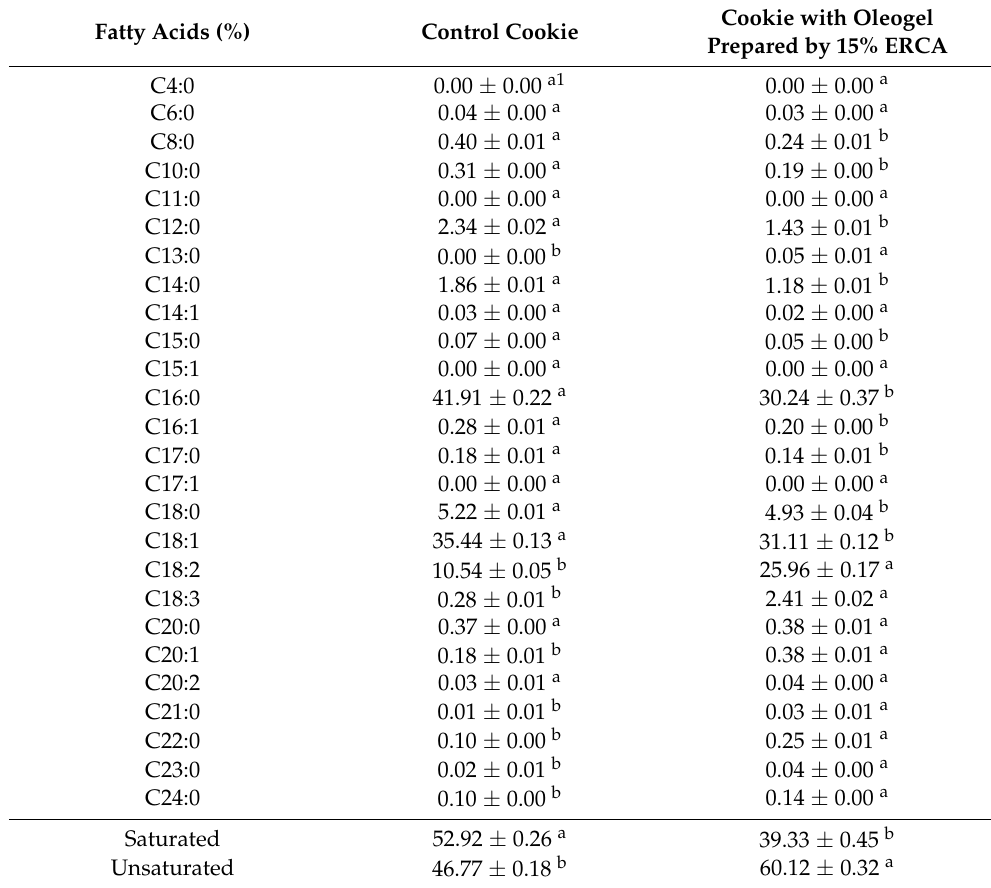
Table 4. Compositions of fatty acids in control cookie and cookie prepared with oleogel prepared by 15% esterified rice flour with citric acid (ERCA). Cookie with Oleogel Control Cookie Prepared by 15%